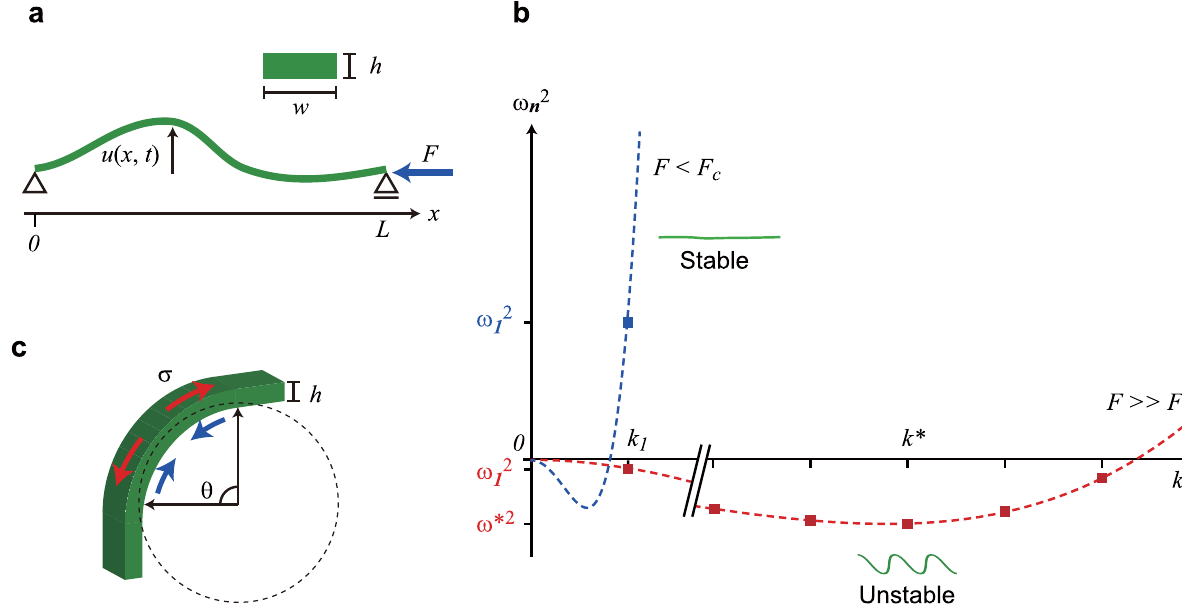
Figure 6. Theoretical analysis on deformation of a nanofiber. (a) The model used in the linear stability analysis. The inset shows the cross section of the nanofiber. ( b) Schematic plots of Eq. (4). ( c ) Schematic representation of stresses in a bent slender elastic body. Red arrows represent the tensile stress generated in the outer portion, and blue arrows the compressive stress generated in the inner